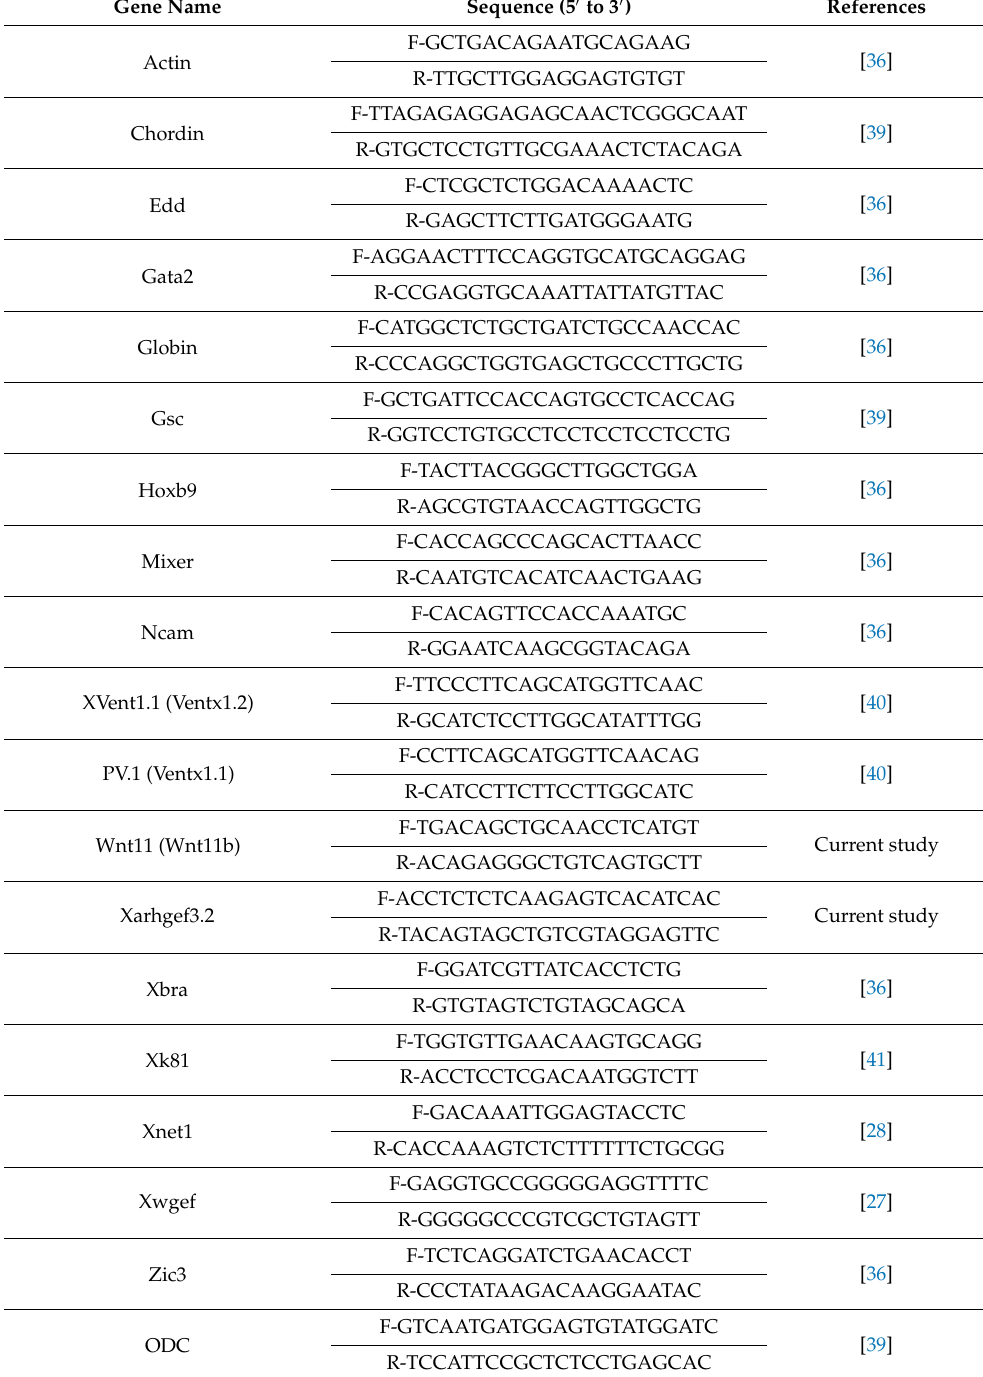
Table 1. Primers used for RT-PCR